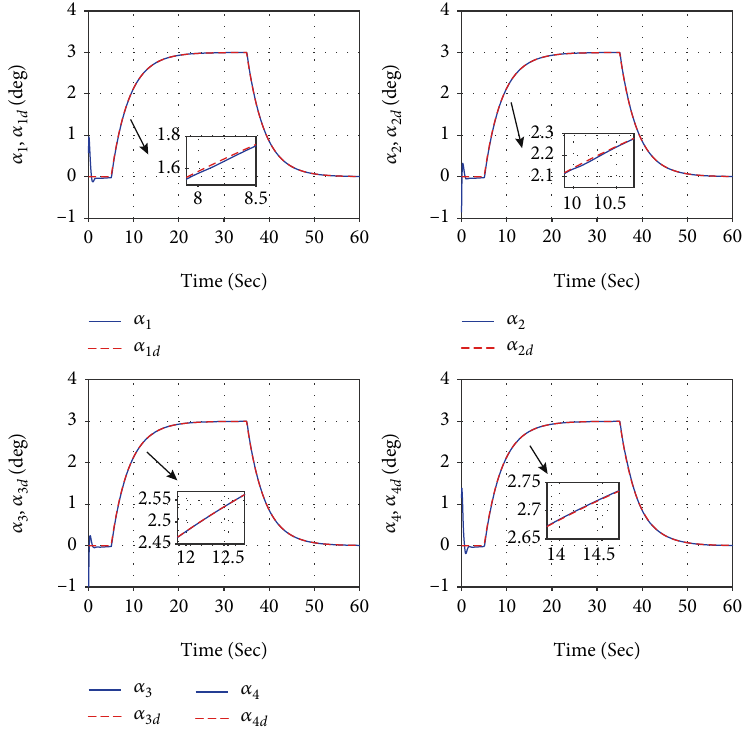
Figure 5: Attack angles α